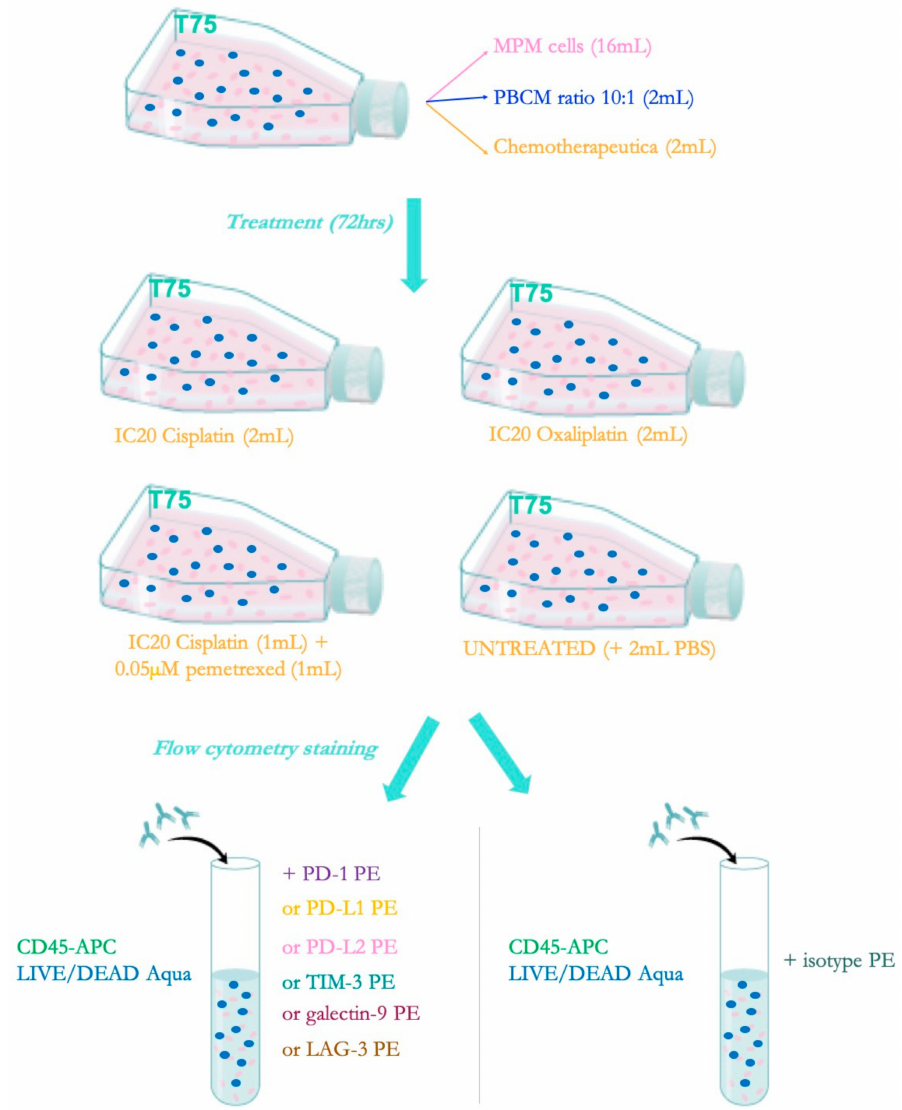
Figure 5. Experimental set-up allogeneic co-culture assay with flow cytometric read-out for chemotherapy-induced modulation of ICP expression. Co-cultures of MPM cells and PBMC were either untreated or treated with cisplatin, pemetrexed, cisplatin + pemetrexed or oxaliplatin to determine the influence of the treatment on immune checkpoint expression. PBMC and MPM cells were harvested and transferred into tubes. For each condition, the PBMC and MPM cells were stained with PE-labelled antibodies against the targets of interest: PD-1, PD-L1, PD-L2, TIM-3, LAG-3, and galectin-9. CD45 and LIVE / DEAD Aqua was added to each well to distinguish MPM cells from PBMC and viable from dead cells,